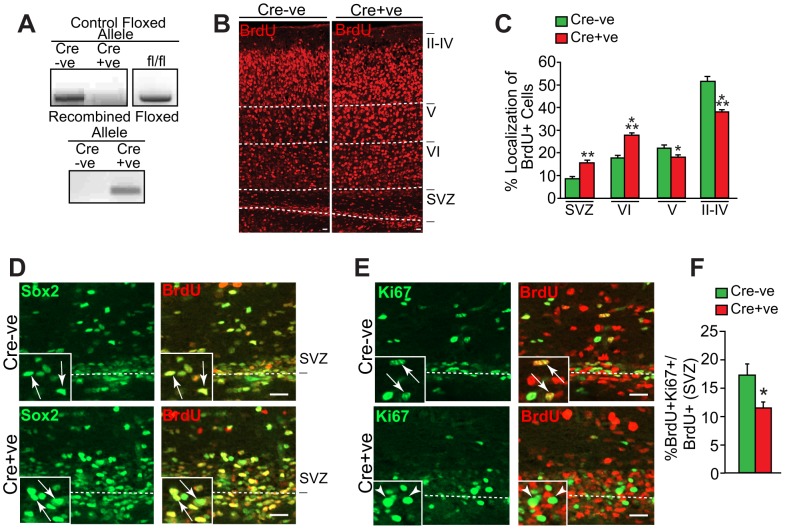
Perturbations in postnatal cortical precursors in Snailfl/fl;nestin-cre mice.(A) PCR analysis of genomic DNA isolated from the cortex of P7 Snailfl/fl mice that were positive (Cre+ve) or negative (Cre-ve) for the nestin-cre transgene showing the 480 nucleotide product from the intact floxed allele in the top panel, and the 492 nucleotide product generated from the floxed allele after Cre-mediated recombination (bottom panel). The top panel also shows genomic DNA from an adult Snailfl/fl mouse as a positive control. (B–F) Snailfl/fl mice that were positive (Cre+ve) or negative (Cre-ve) for the nestin-cre transgene were labelled with BrdU at E13 and their cortices were analyzed at P7. (B) Fluorescence micrographs of coronal cortical sections immunostained for BrdU (red). The dotted white lines demarcate the different cortical layers and the subventricular zone (SVZ), which comprises the precursor region in the postnatal cortex. Scale bar, 20 µm. (C) Quantification of sections similar to those in B for the relative location of BrdU-positive cells. (*p<0.05, **p<0.01, ***p<0.001; n = 3 and 4 Snailfl/fl mice Cre+ve and Cre-ve, respectively). (D) Confocal micrographs of the SVZ immunostained for BrdU (red) and Sox2 (green). The panels on the left show Sox2 alone and those on the right show the merges. The boxed insets show labelled cells at higher magnification, and the arrows denote double-labelled cells. Scale bar, 20 µm. (E) Confocal micrographs of the SVZ immunostained for BrdU (red) and Ki67 (green). The panels on the left show Ki67 alone and those on the right show the merges. The boxed insets show labelled cells at higher magnification. The arrows denote double labeled cells and arrowheads Ki67-negative, BrdU-positive cells. Scale bar, 20 µm. (F) Quantification of sections as in E for the proportion of BrdU-positive cells in the SVZ that are also Ki67-positive. (*p<0.05; n = 3 and 4 Snailfl/fl mice Cre+ve and Cre-ve, respectively).